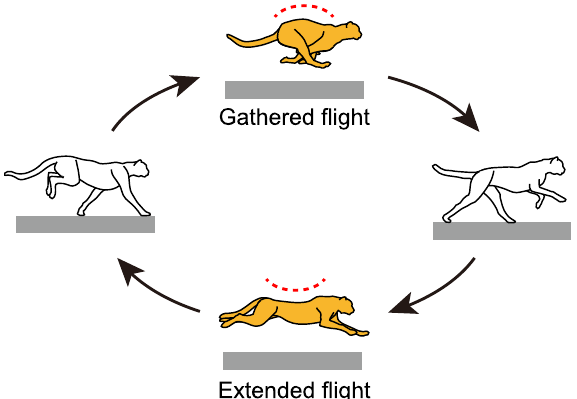
Figure 1. Cheetah galloping involves two types of flights through spine movement: gathered and extended.